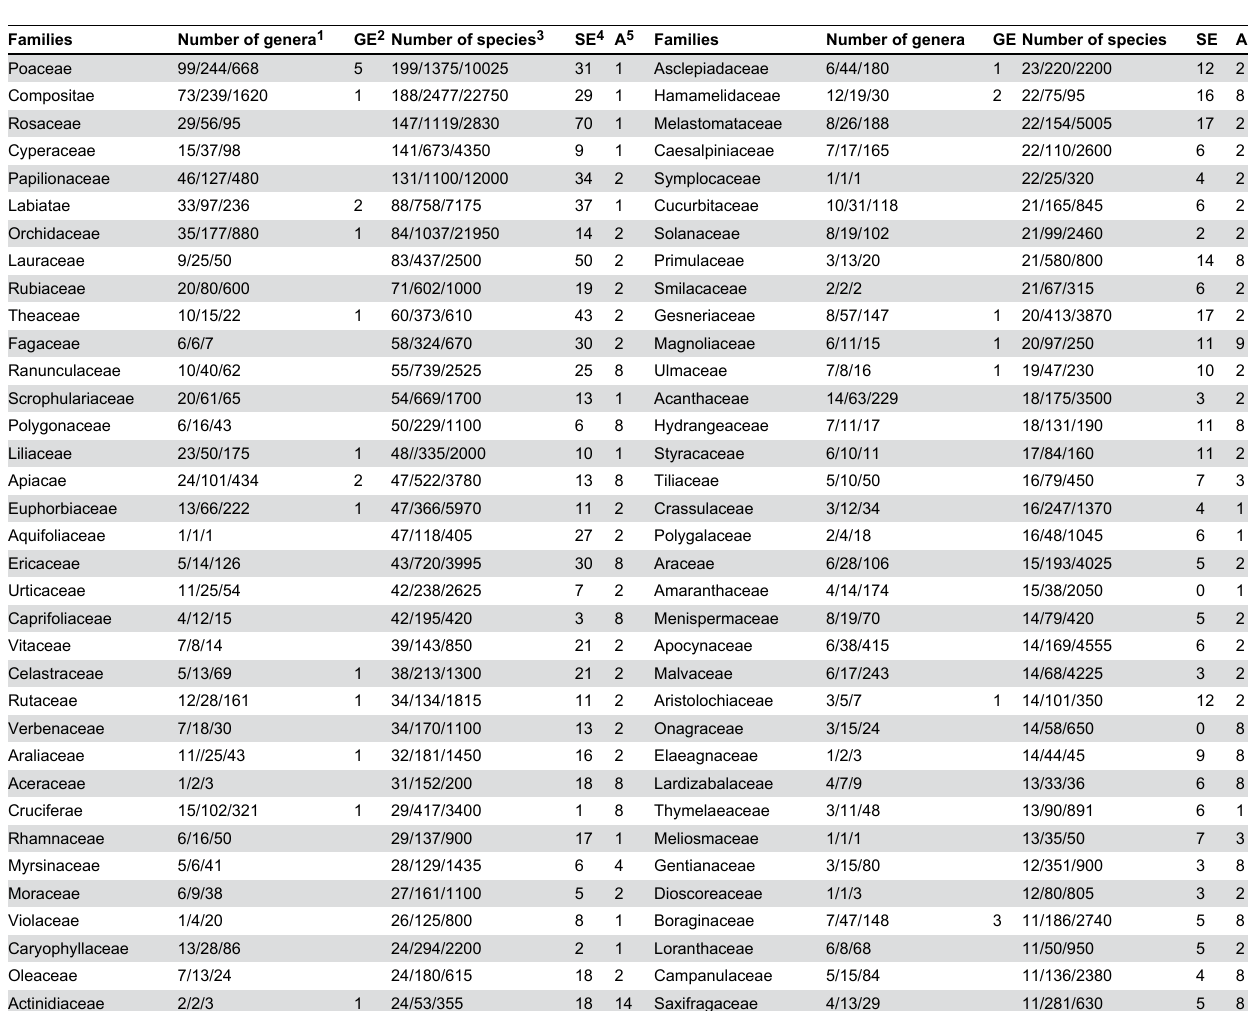
Table 3. Ranking of families (with >10 species) in Mount Jinggangshan region based on numbers of genera and species